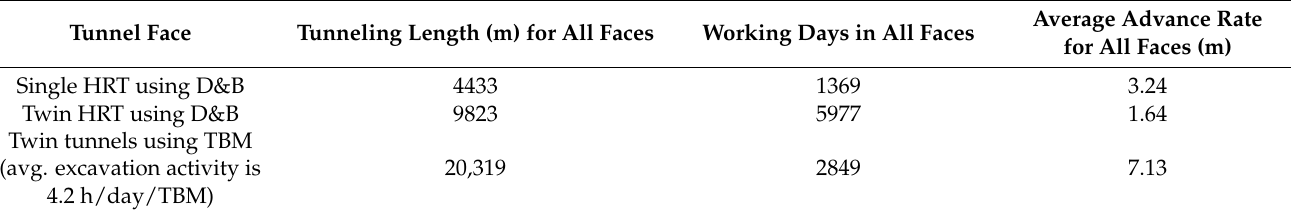
Average Advance Rate for All Faces (m)